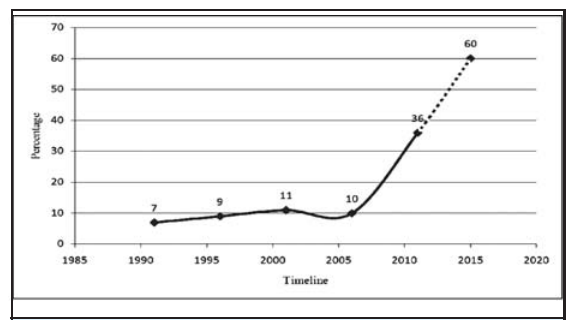
Figure 2. Trend of skilled care at birth in Nepal.